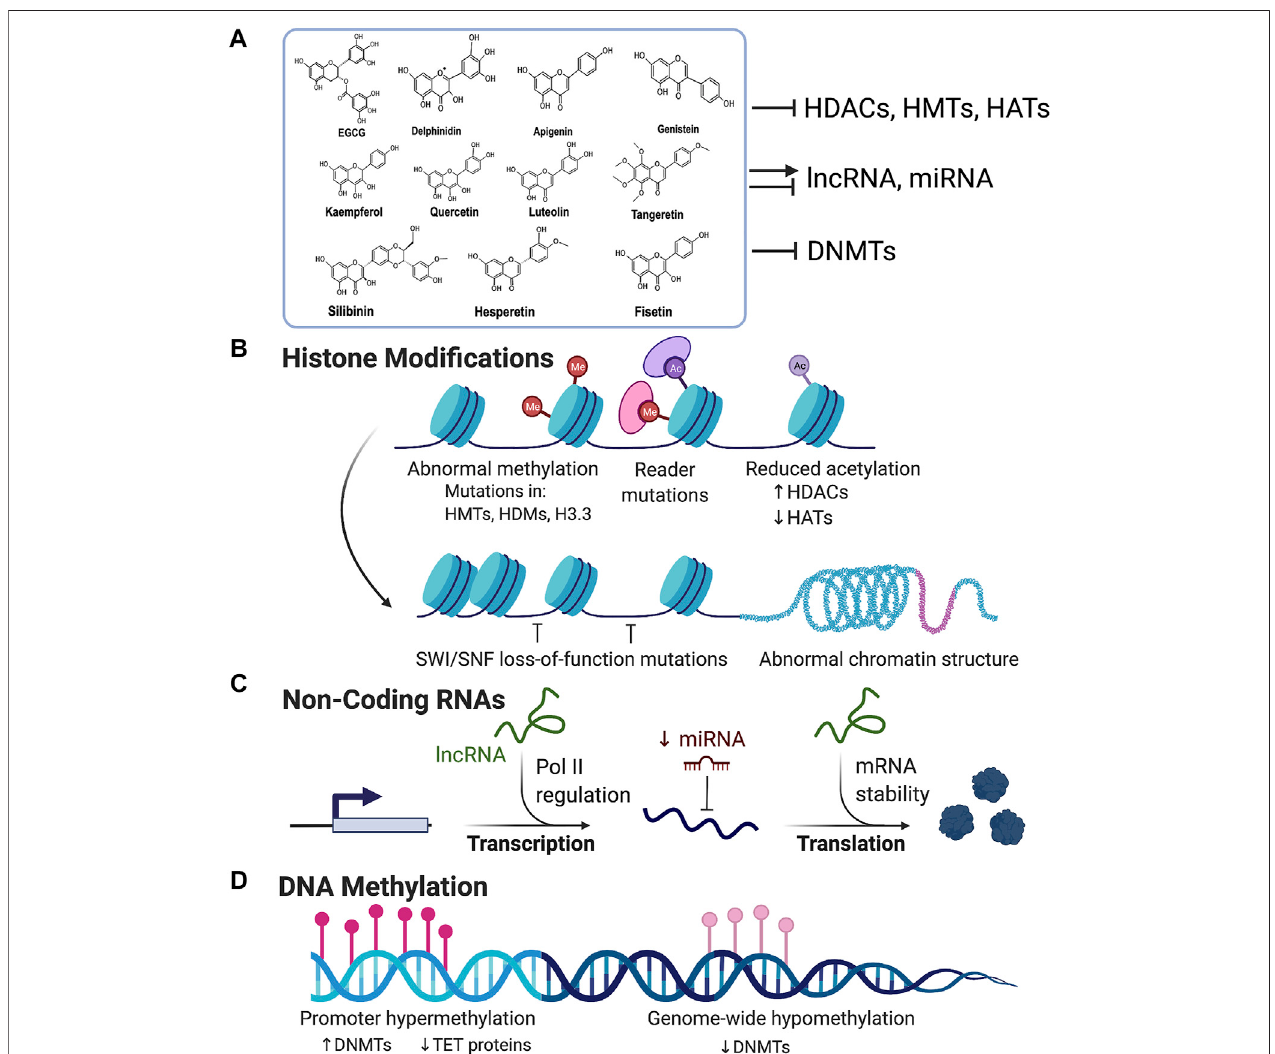
FIGURE2| Flavonoidsasepigeneticmodulatorsincancer: (A) Flavonoids arepolyhydroxycompoundsfoundinvariousplantsandgenerallyconsistoftwophenyl ringsandaheterocyclicring.FlavonoidsarereportedtoexhibitinhibitoryactivityforHDACs,HMTs,HATs,andDNMTs.TheycanalsoeitherinhibitoractivatemiRNAand lncRNA. (B) Illustration showing various mechanisms of histone modi fi cations associated with carcinogenesis. Flavonoids can block the aberrant expression of HMTs, HATs, and HDACs, and activate tumor suppressor genes and block the expression of oncogenes. (C) Flavonoids can either activate or repress non-coding RNAs which regulates chromatin structure and aberrant gene expression in cancer. (D) Promoter hypermethylation and genome-wide hypomethylation are associated with cancer. Flavonoids can inhibit DNA Methyl Transferases (DNMTs) and thus prevent hypermethylation of gene promoters like tumor suppressor genes thereby reactivating their expression. (Created with